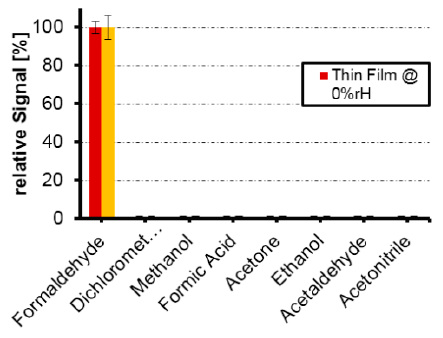
Figure 6. Selectivity patterns of MIP thin films and MIP nano-particles layers showing relative signals [30].